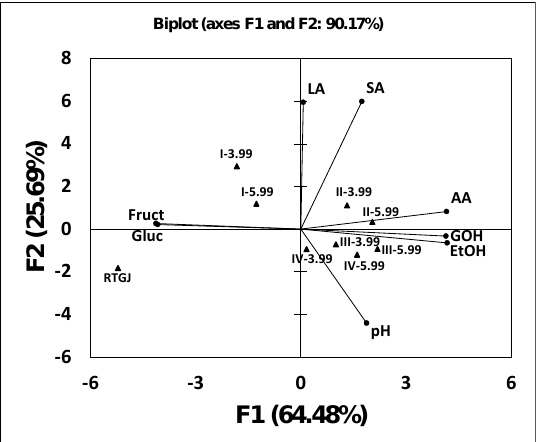
Figure 4. Principal component analysis based on the final pHs and the concentrations of glucose (Gluc), fructose (Fruct), alcohols (EtOH: ethanol and GOH: glycerol) and organic acids (LA: lactic acid, AA: acetic acid, SA: succinic acid) in the nonfermented red table grape juice (RGTJ) and fermented samples obtained from fed-batch fermentations A (I − 3.99, II − 3.99, III − 3.99 and IV − 3.99) and B (I − 5.99, II − 5.99, III − 5.99 and IV − 5.99).